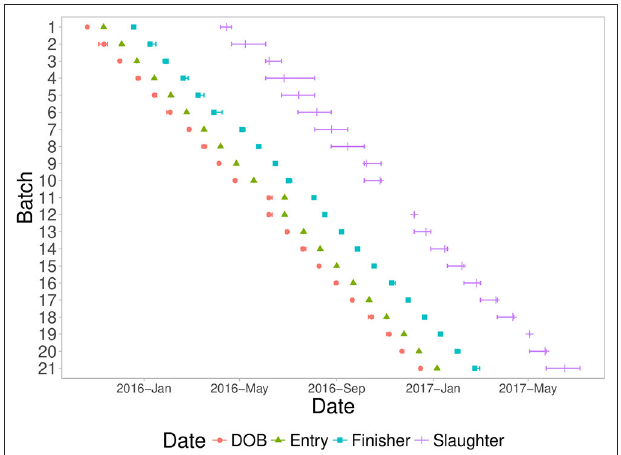
FIGURE 2 | Age at death of the 344 animals that died prior to